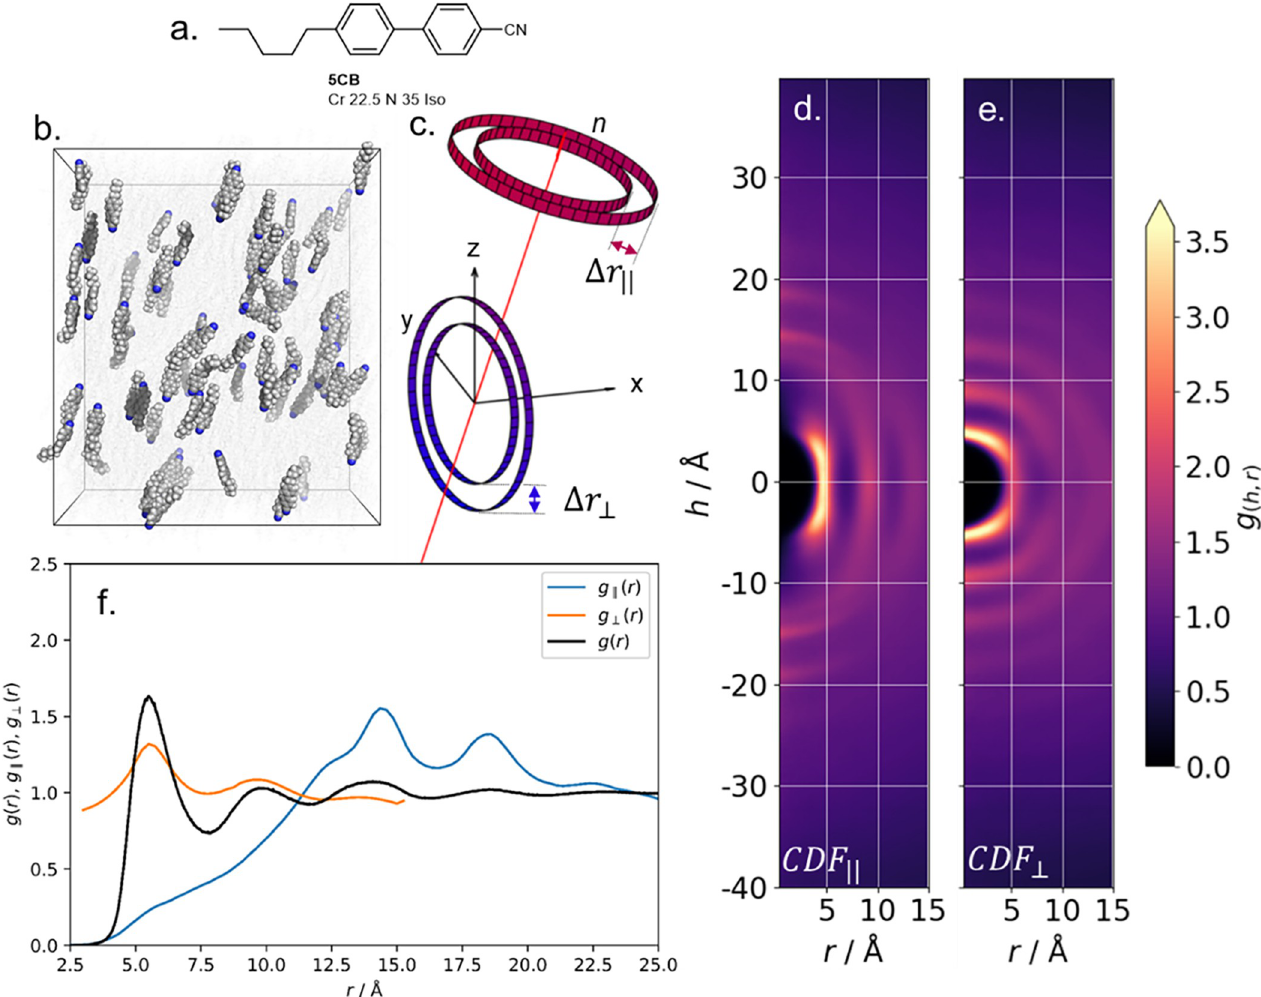
Fig 2. (a) Molecular structure and transition temperatures (˚C) of 5CB; (b) instantaneous configuration of 5CB in the nematic phase at 293 K, the simulation has < P 2 > = 0.56 ± 0.019 over the 50 ns MD run; (c) schematic showing the nematic director from (b) as a red arrow, and (exaggerated) cylindrical shells whose radius ( Δ r ) forms a plane orthogonal ( Δ r k ) or parallel ( Δ r ? ) to the director, used to calculate the CDF parallel and perpendicular to the director, respectively; (d) parallel and (e) perpendicular CDF plots for the nematic simulation of 5CB as generated by cylindr ; (f) radial distribution functions (RDF) for the same simulation, with the RDF resolved into parallel and perpendicular components according to Eq 2 and Eq